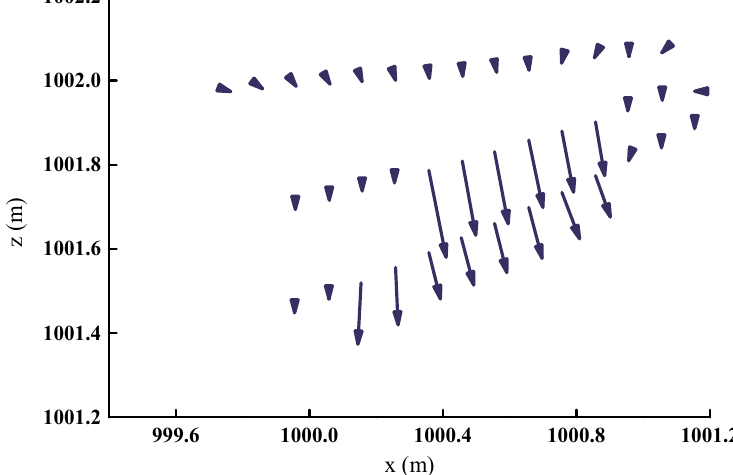
Figure 8. Total displacement vector of overlying strata.